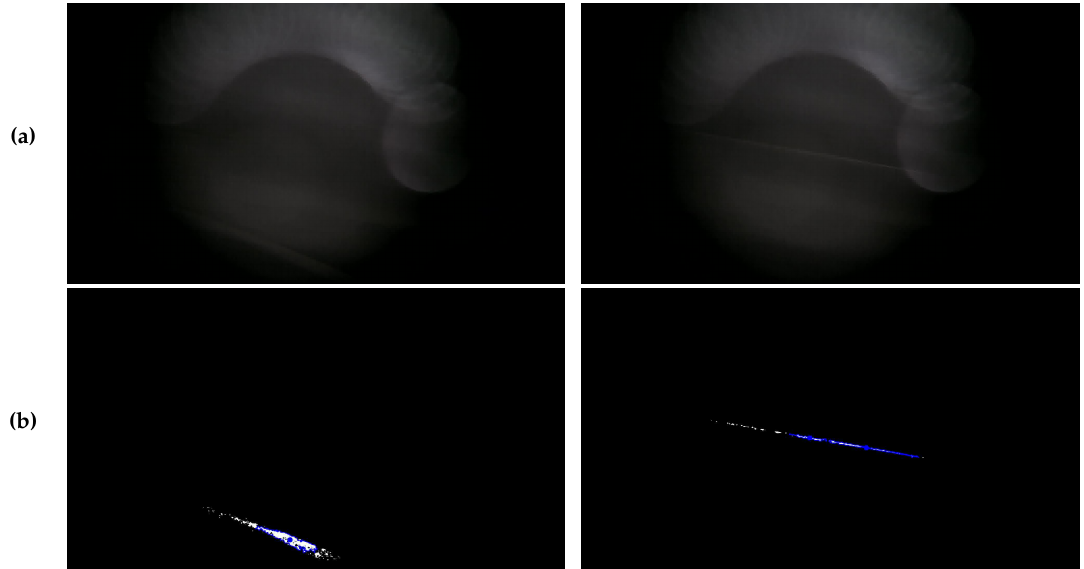
Figure 6. Contour Detection Particle Counting: CDPC The original recordings ( a ) undergo background subtraction, blur and binarization before a contour detection algorithm isolates continuous patches, of which all with an area exceeding a preset threshold are counted ( b